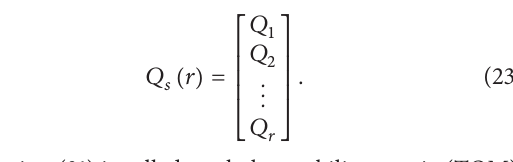
Table 1: Singular values of system observable matrix 𝑄